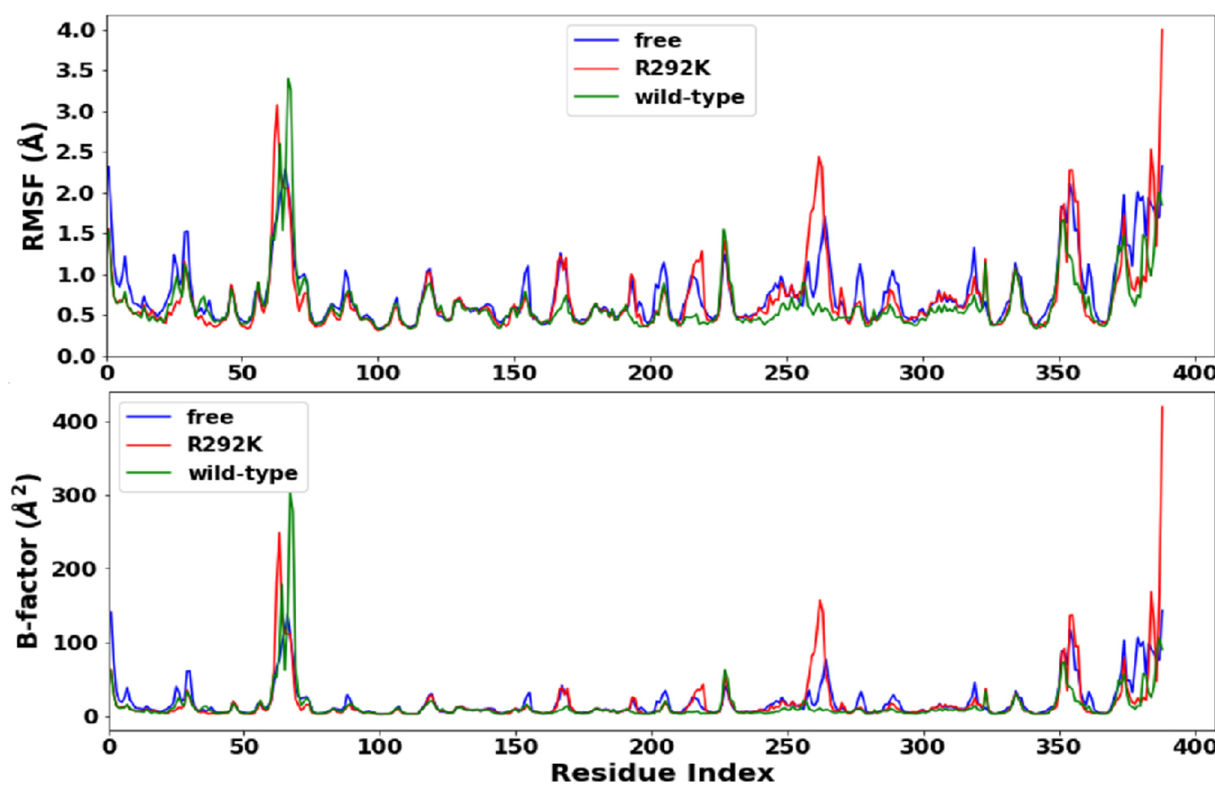
Figure 4. RMSF ( top ) and B-factors ( bottom ) plots of C- α atoms of peramivir-free neuraminidase, peramivir–wild-type, and peramivir–R292K neuraminidase complexes over simulation time (ps).